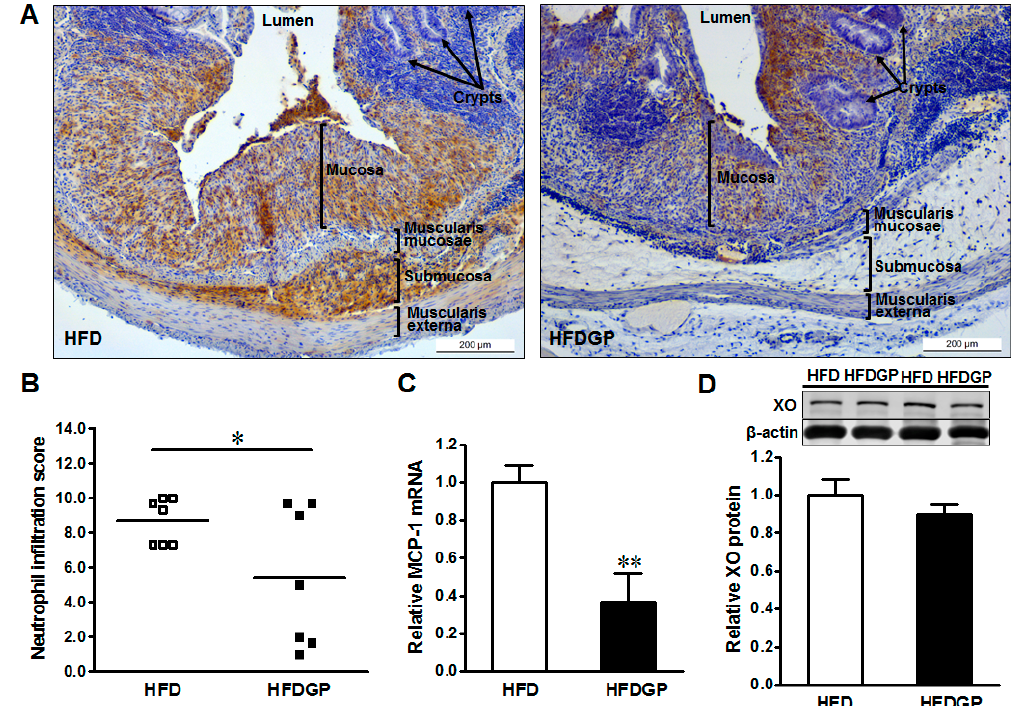
Figure 2. Immunohistochemical staining of neutrophils in distal colonic tissues of high-fat diet (HFD) ( □ ) or high-fat diet supplemented with green pea (HFDGP) ( ■ ) fed DSS-colitis mice. ( A ) Representative images of neutrophil staining; ( B ) Neutrophil quantified score; ( C ) mRNA expression of MCP-1; ( D ) Representative immunoblotting bands and statistical data of xanthine oxidase (XO). Means ± SEM, n = 7, * p ≤ 0.05, ** p ≤ 0.01.